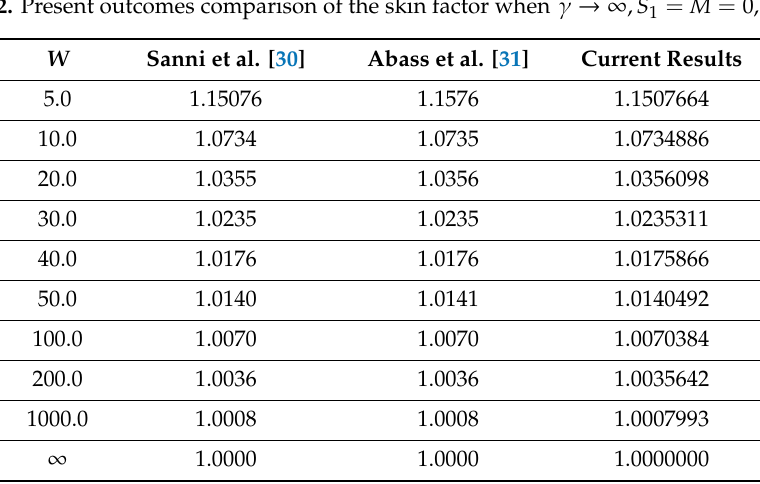
Table 2. Present outcomes comparison of the skin factor when γ → ∞ , S 1 = M = 0, φ =